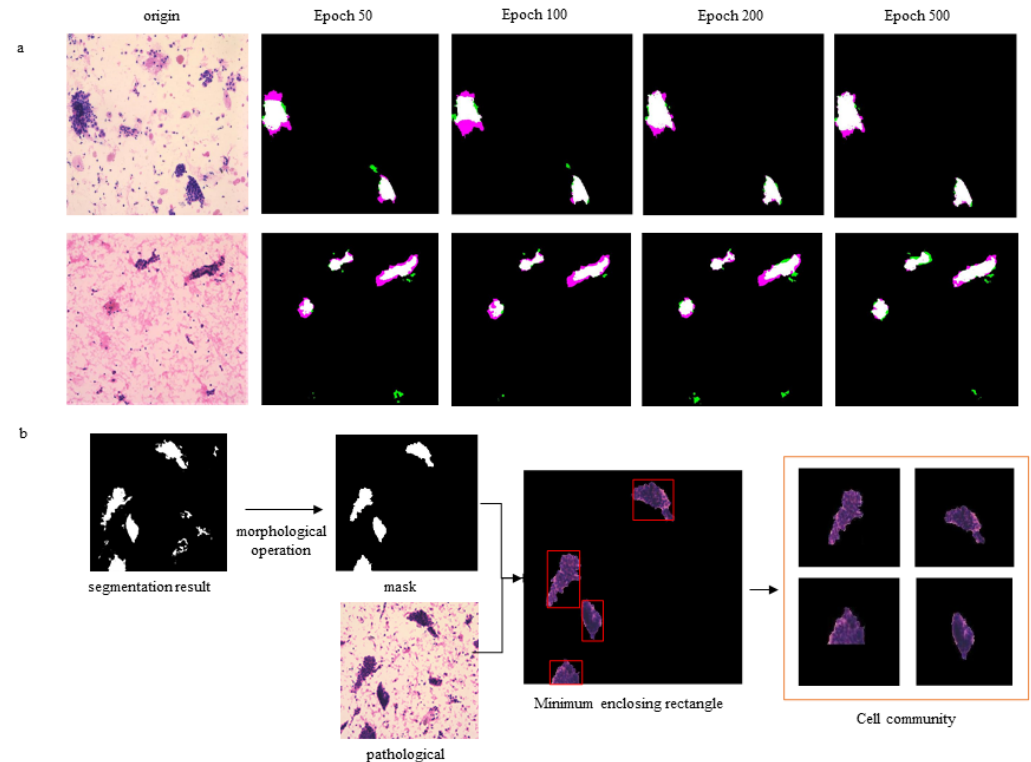
Figure 3. The effect of segmentation. ( a ) Variation of segmentation accuracy with training epochs. Compared with the ground truth (mask was manually marked by the physician), the red areas were not predicted in the mask of the model training; compared with the ground truth, the green areas represent other predicted areas in the mask of model training. ( b ) The process of ECC acquisition.